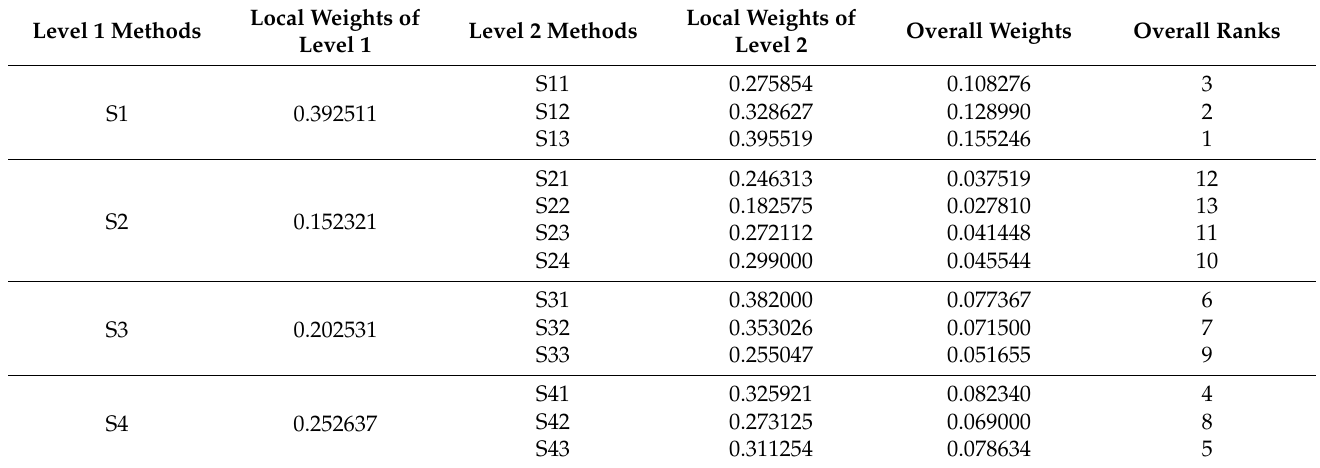
Table 11. The overall weights and rankings of methods.